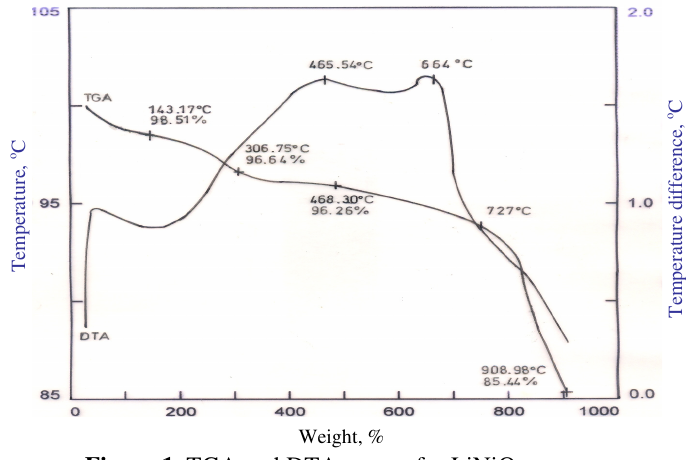
Figure 1. TGA and DTA curves for LiNiO